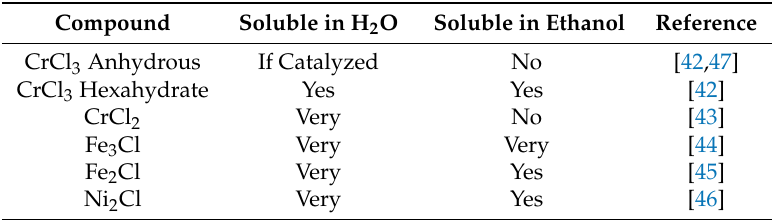
Table 2. Chloride solubility in